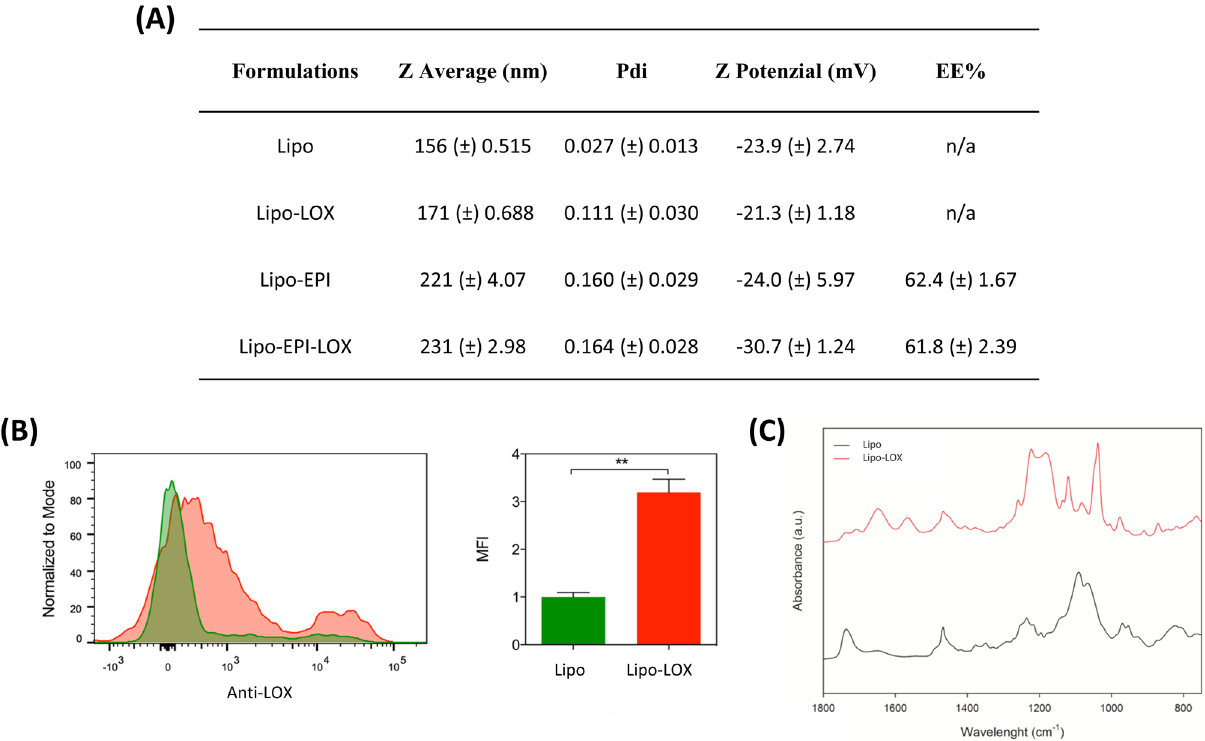
Figure 1. ( A ) Physical characterization of lipid-based nanocarriers. ( B ) Cytometry analysis of Lipo and Lipo- LOX formulations. ( C ) FTIR analysis of Lipo and Lipo-LOX